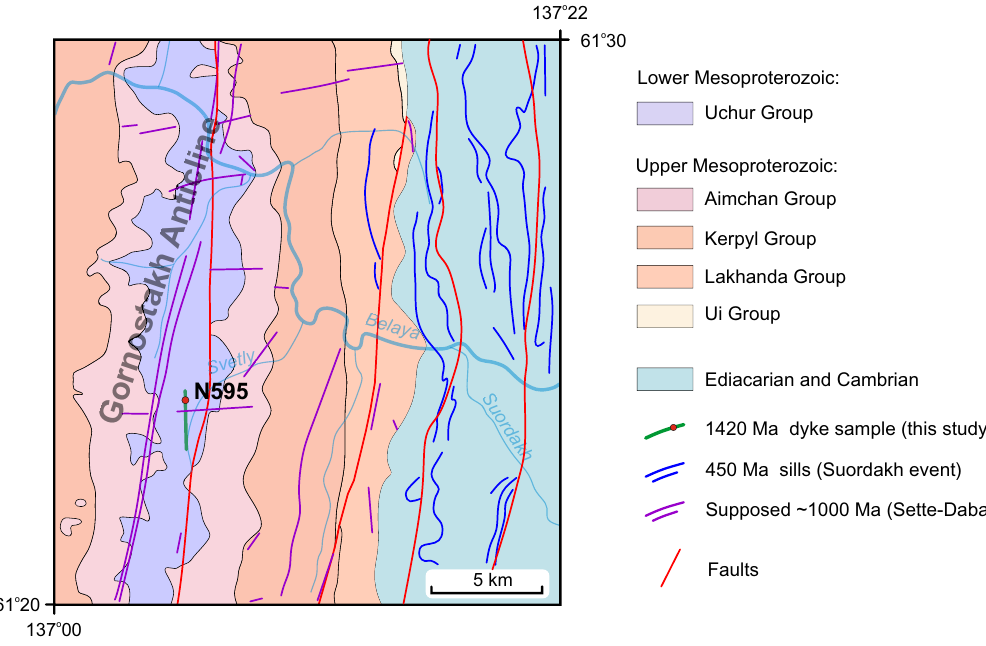
Figure 2. Geological setting of the central part and eastern limb of the Gornostakh Anticline (Belaya River area) and location of sampled dolerite dyke in this study (geology after 25 , modified and simplified). Ca 450 Ma sills (Suordakh event) from 24 .